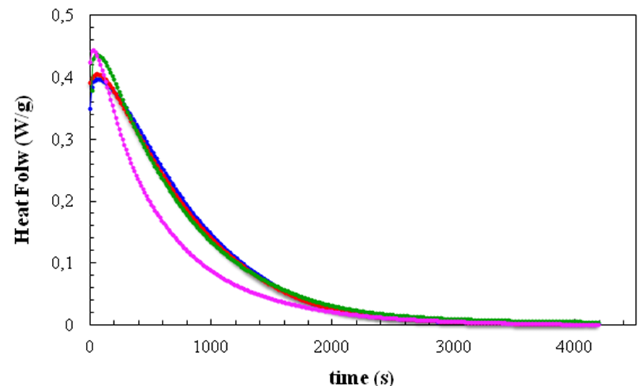
Figure 2. DSC scans for the isothermal cure at 70 °C of the resin/ hyperbranched polymer (HBP) without clay (blue curve) and for the nanocomposites with 2 wt% (red), 5 wt% (green) and 10 wt% (pink) clay